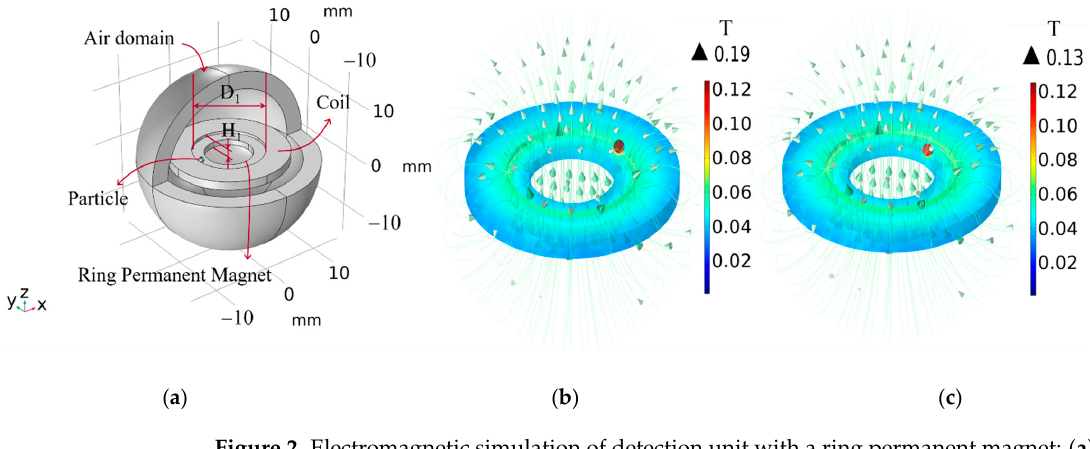
Figure 2. Electromagnetic simulation of detection unit with a ring permanent magnet: ( a ) 3D model of the detection unit with a particle; ( b ) Magnetic flux density mode distribution of the particle at position (5.5 mm, 0 mm, 0.5 mm); ( c ) Magnetic flux density mode distribution of the particle at position (4.125 mm, 0 mm, 0.5 mm).